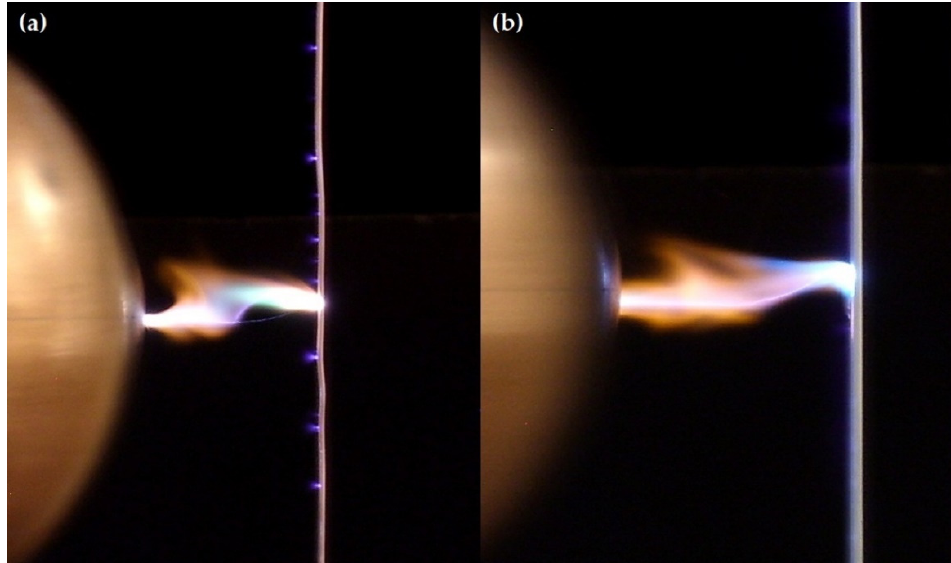
Figure 15 . The enlarged images of the upper parts of the antennas subjected to bidirectional dis- charges: ( a ) copper and ( b ) aluminum (both 8 s exposure). Image ( b ) is more enlarged than ( a ). Different corona patterns can be noticed.